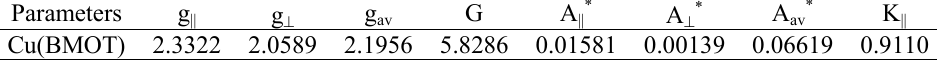
Table 4. Spin Hamiltonian and orbital reduction parameters of Cu(II) complexes